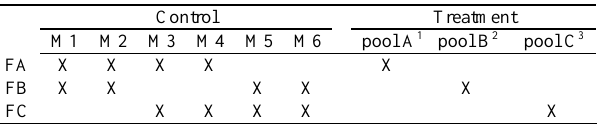
Table 1. Directed crossings of female (F) Rhamdia quelen oocytes with semen of a single male (M) (control) and with pooled semen from four males (treatment). 1 pool A (M1+M2+M3+M4), 2 pool B (M1+M2+M5+M6) and 3 pool C